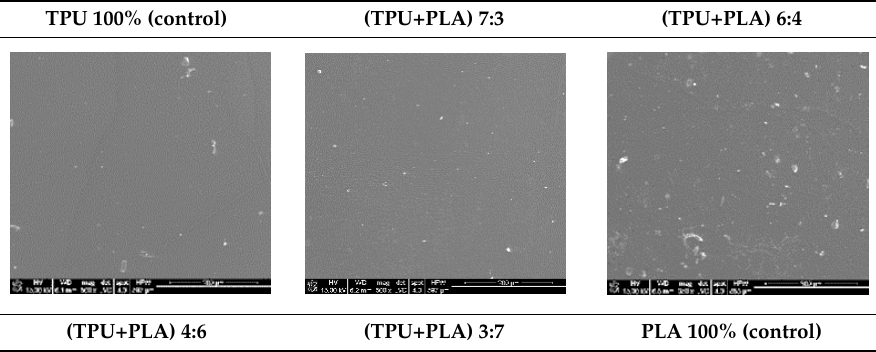
Table 1. SEM images of thin films made from PLA, TPU and (TPU+PLA) blends.